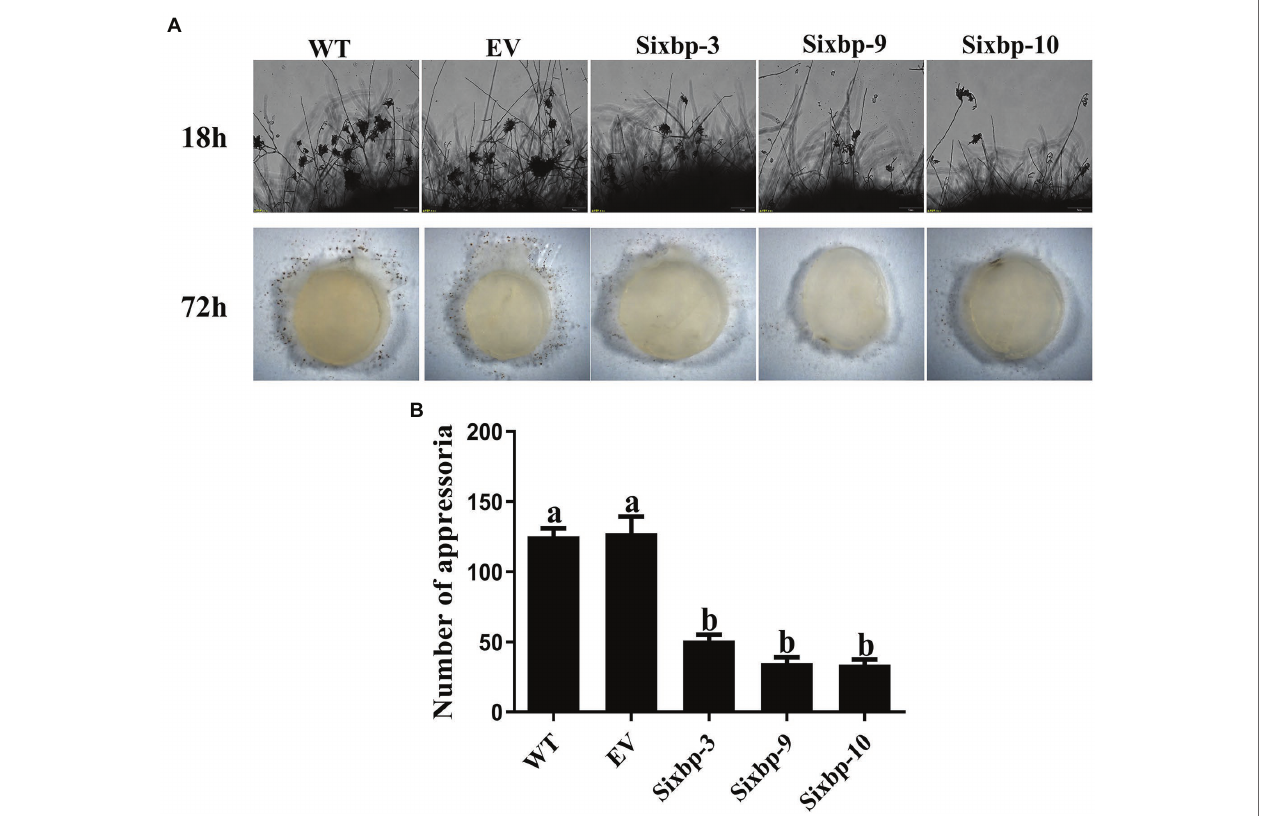
FIGURE 5 | Compound appressoria formation was observed in WT, EV, and RNAi strains. (A) Appressoria was induced by placing the agar plugs on glass slides, and microscopic observations were conducted at 18 and 72 h after induction. (B) The number of appressoria differentiated from each strain at 18 h. Different letters above bars represent significant differences ( p < 0.05) as determined using a one-way Duncan’s test. The experiment was repeated three times. Compound appressoria formation of each strain in different replicates showed similar